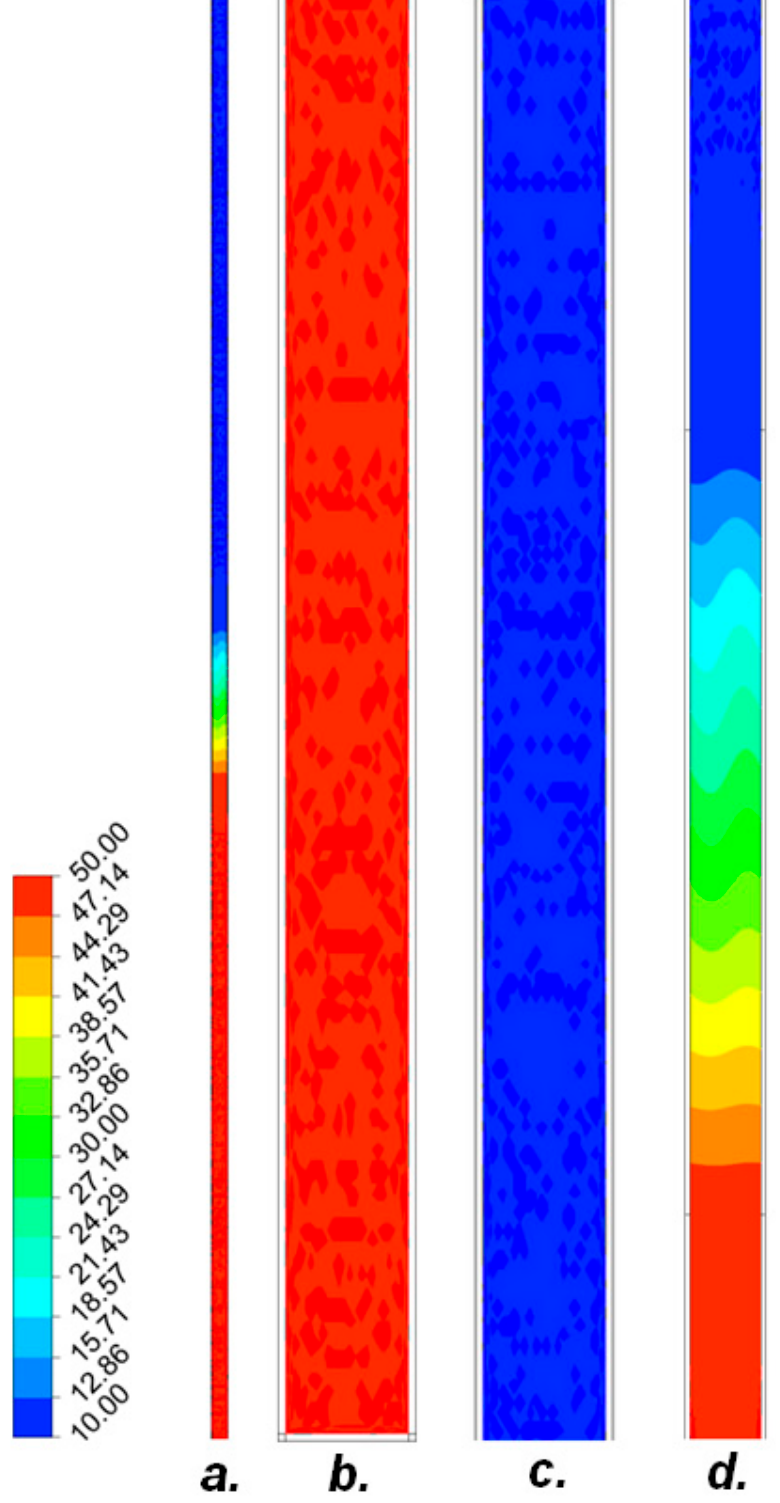
Figure 3. Temperature distribution in the heat pipe. ( a ) Total heat pipe; ( b ) evaporator section; ( c ) condenser section, ( d ) isothermal section.